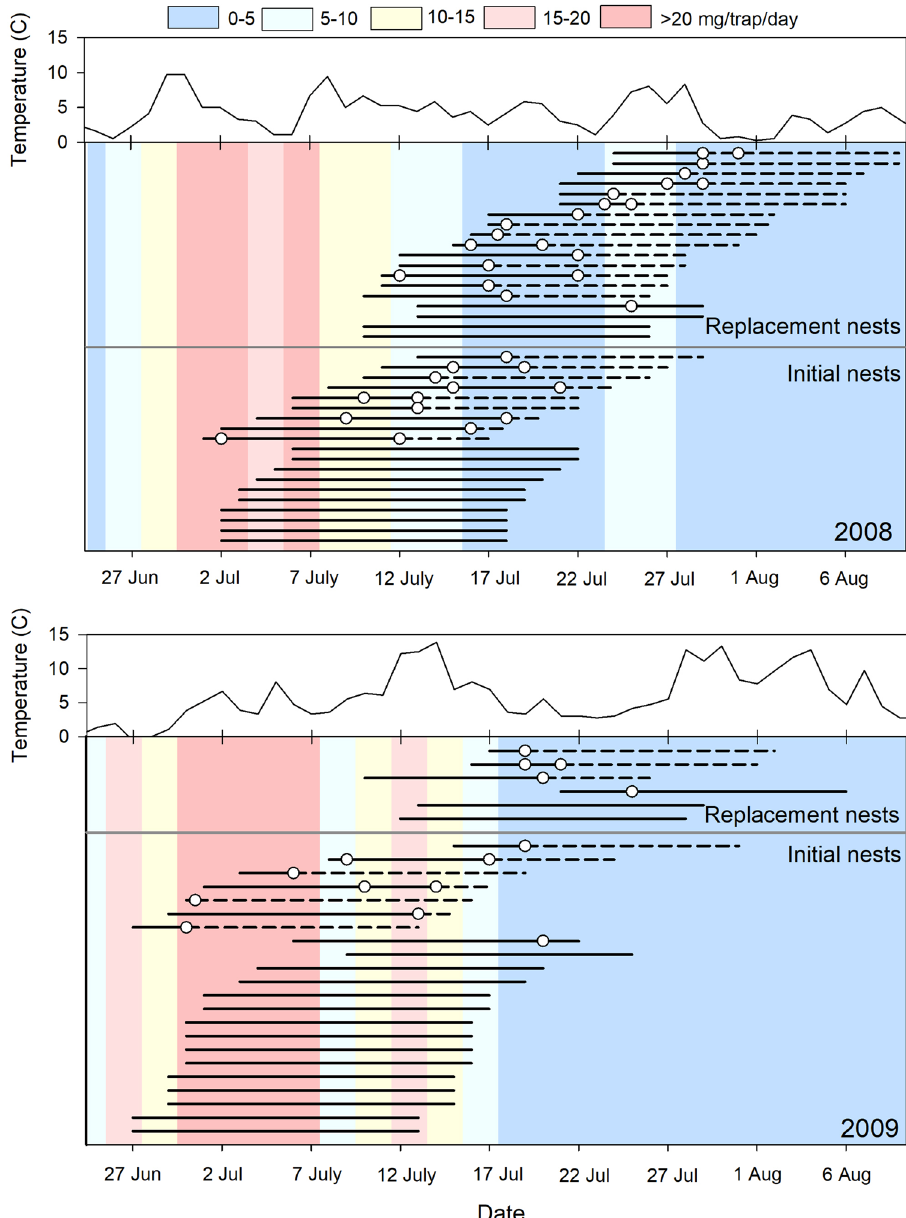
Figure 2. Phenology of Dunlin broods from initial (below solid gray horizontal line) and replacement nests (above solid gray horizontal line) in relation to invertebrate availability (background colors) and temperature (line graph) near Utqiaġvik, Alaska, 2008–2009. Each line represents phenology of a given brood from hatching to fledging (16-day period) with broods ordered by fate (i.e., broods with mortality of both chicks are at the top) and hatch date. White dots indicate dates when radio-tagged chicks died (i.e., median date between the last date seen alive and date found dead). Dashed lines after white dots indicate the time till fledgling had a brood remained alive. If death of both chicks occurred on the same day, only one dot is visible on a line. Although no invertebrate data were available after 4 August in 2008 and 8 August in 2009, we assumed these values would be close to zero due to prior